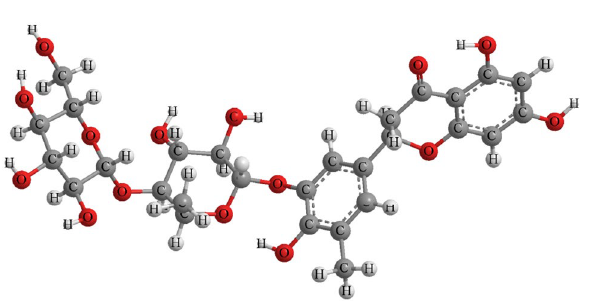
Figure 6. The structure of the new flavonoid compound (Compound I), hesperetin-5 ′